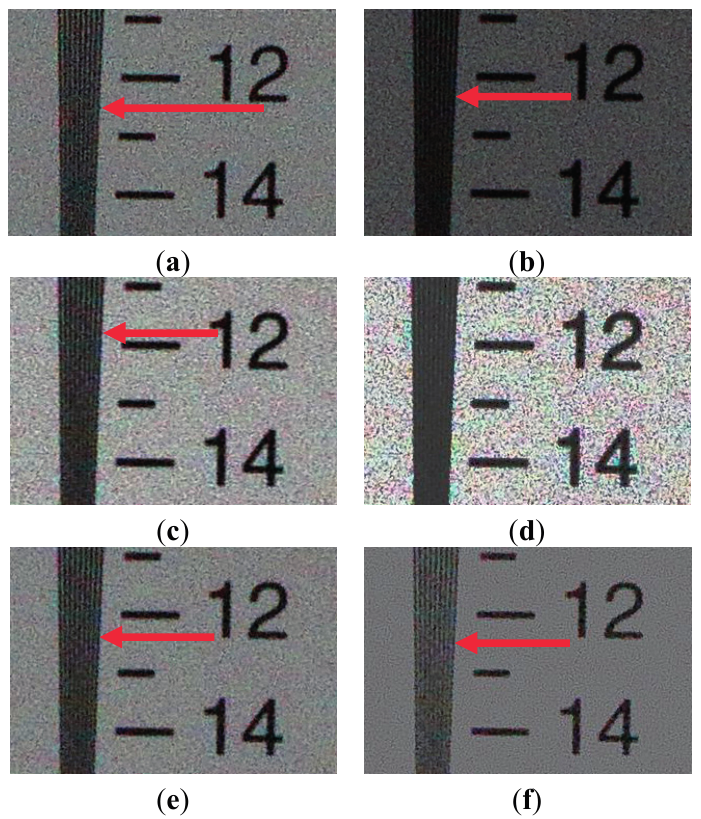
Figure 7. The magnified version of the red box in Figure 6a: ( a ) The reference image with ISO 3200 (EV = 0); ( b ) one-step lower exposure image using ISO 1600 (EV = − 1); ( c ) enhanced image of ( b ) using ordinary two-pixel digital pixel binning; ( d ) enhanced image of ( b ) using Kim’s algorithm; ( e ) enhanced image of ( b ) using Jiang’s algorithm; and ( f ) enhanced image of ( c ) using adaptive eight-pixel digital pixel